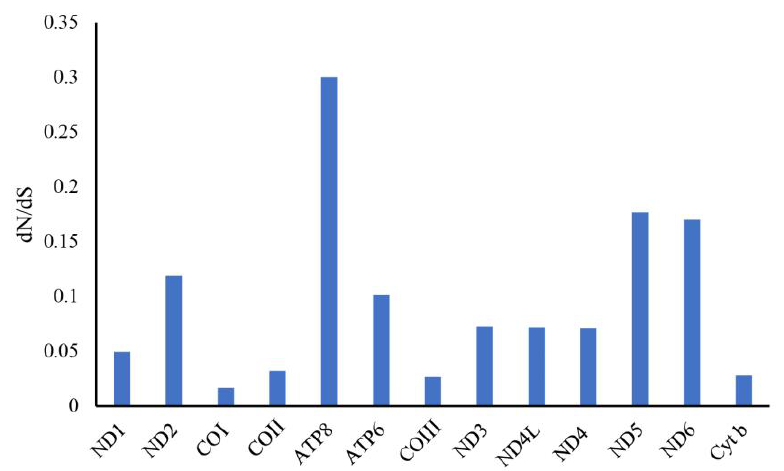
Figure 7. Non- synonymous/synonymous substitution ratios (ω) of the 13 PCGs in the parrotfish mitogenomes.